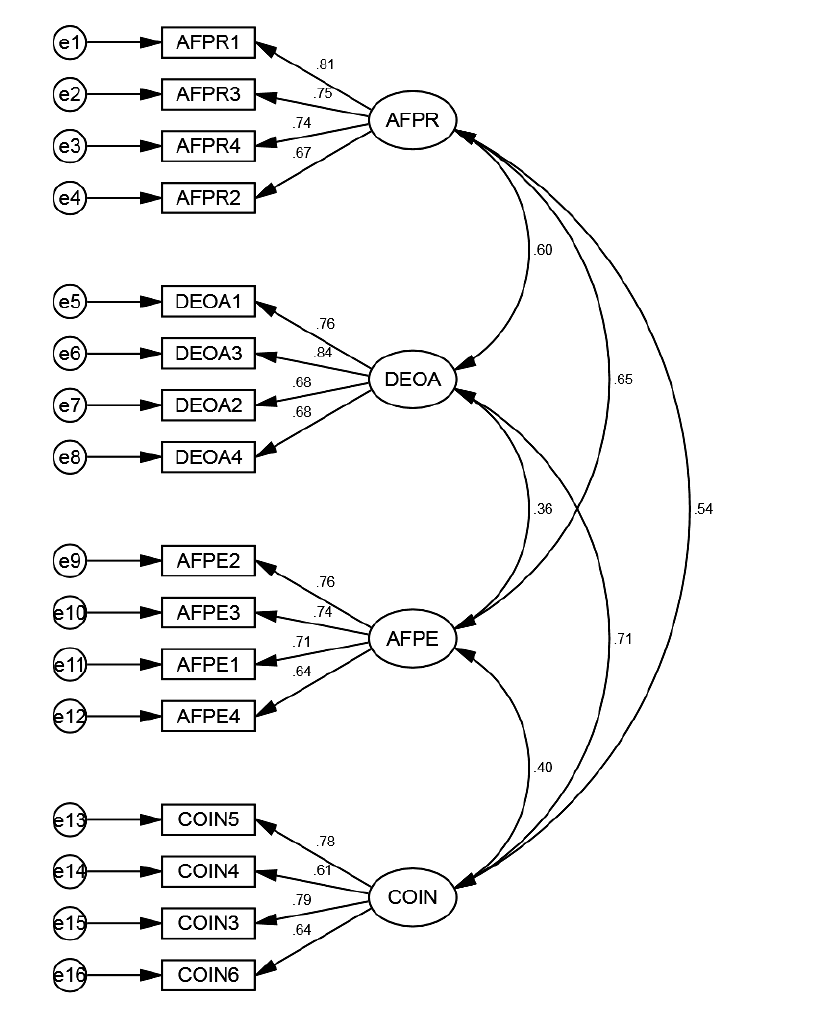
Figure 1. Structural equation model